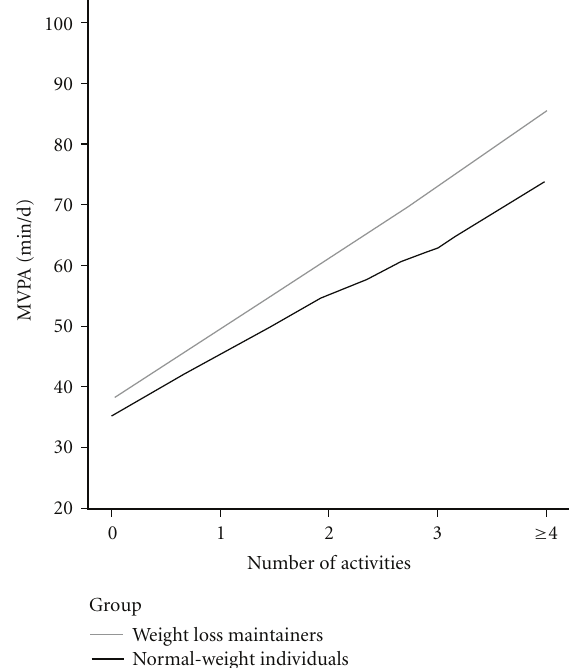
Figure 1: Estimated moderate-to-vigorous physical activity (MVPA) minutes in Weight Loss Maintainers and Normal-weight groups by reported variety or number of di ff erent activities performed. Estimated mean MVPA minutes/day adjusted for age, gender, education level, marital status, current BMI, and daily accelerometer wear